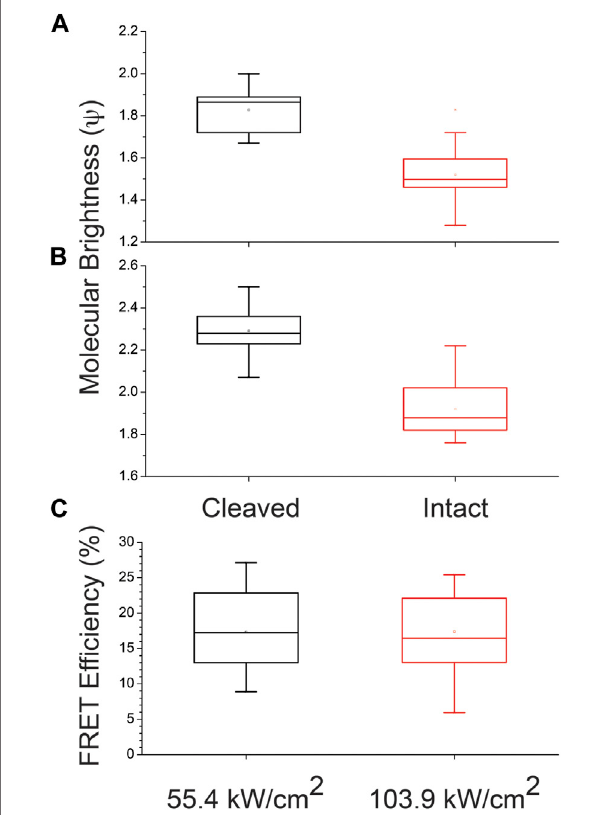
FIGURE 3 | Representative box and whisker plots of the molecular brightness and energy transfer of crTC2.1 (mTurquoise2.1-linker-mCitrine) at the single-molecule level (A) The molecular brightness ( ψ , kHz/molecule) of intactandenzymaticallycleavedcrTC2.1inNaPibuffer,measuredunder 405-nm excitation (7.3 μ W or 55.4 kW/cm 2 ) and 475/50 nm detection (B) The molecular brightness of intact and enzymatically cleaved crTC2.1 in NaPi buffer, measured under 405 nm excitation at slightly higher laser intensity (103.9 kW/cm 2 or 13.6 μ W) (C) The corresponding FRET ef fi ciency of crTC2.1 as estimated using the molecular brightness of both intact and cleaved construct. The line running through each box is the median value for the range of data set (number of trials (cid:2) 18) being